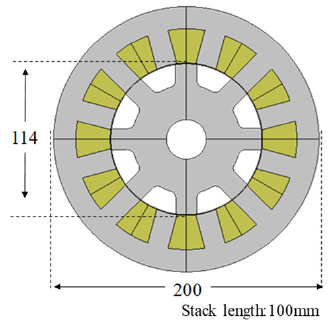
Figure 10. Dimension of designed SRM. Table 3. Specifications of SRM.